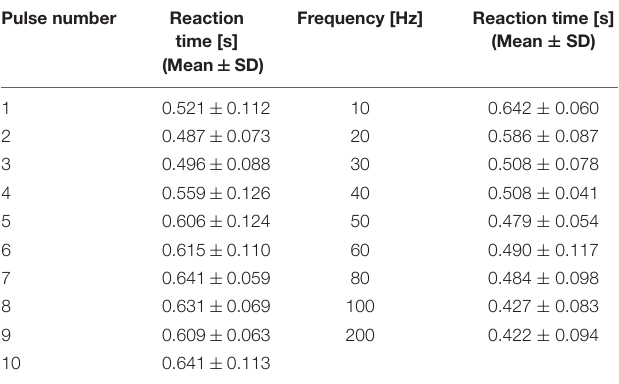
FIGURE 3 | (A) Experimental perception threshold variation with pulse number by a pulse-train electrical stimulation (mean value and standard deviation, n = 8), and (B) its normalization by the average of the thresholds from six to ten pulses (mean value and standard deviation). TABLE 1 | The reaction time of perception threshold at a different number of pulses and frequencies.